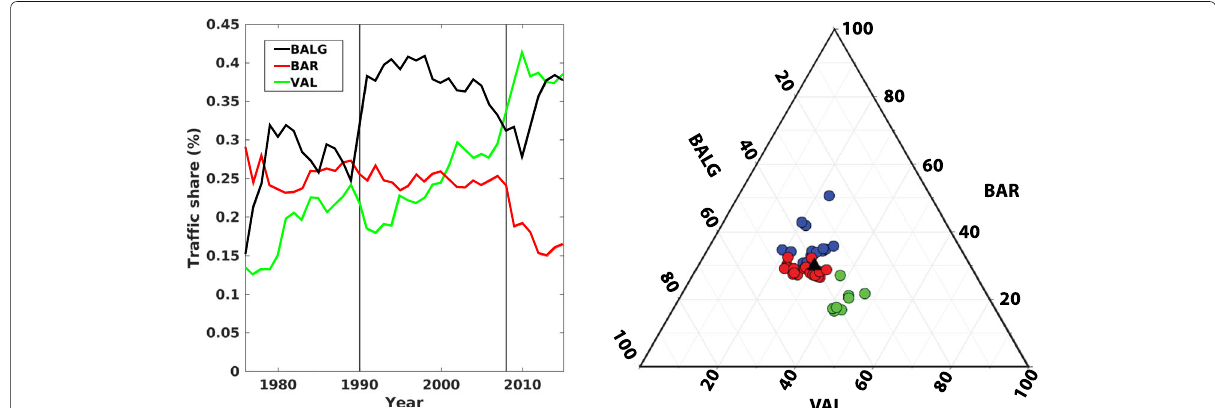
Fig. 3 (left) Traffic share evolution of the three biggest ports (%). (right) Ternary diagram of the BALG/BAR/VAL traffic composition. Blue dots correspond to the period 1976–1989 (before containerization boom), red dots correspond to the period 1990–2007 (before the crisis) and green dots correspond to the period 2008–2015. The center of the sample is shown as a black